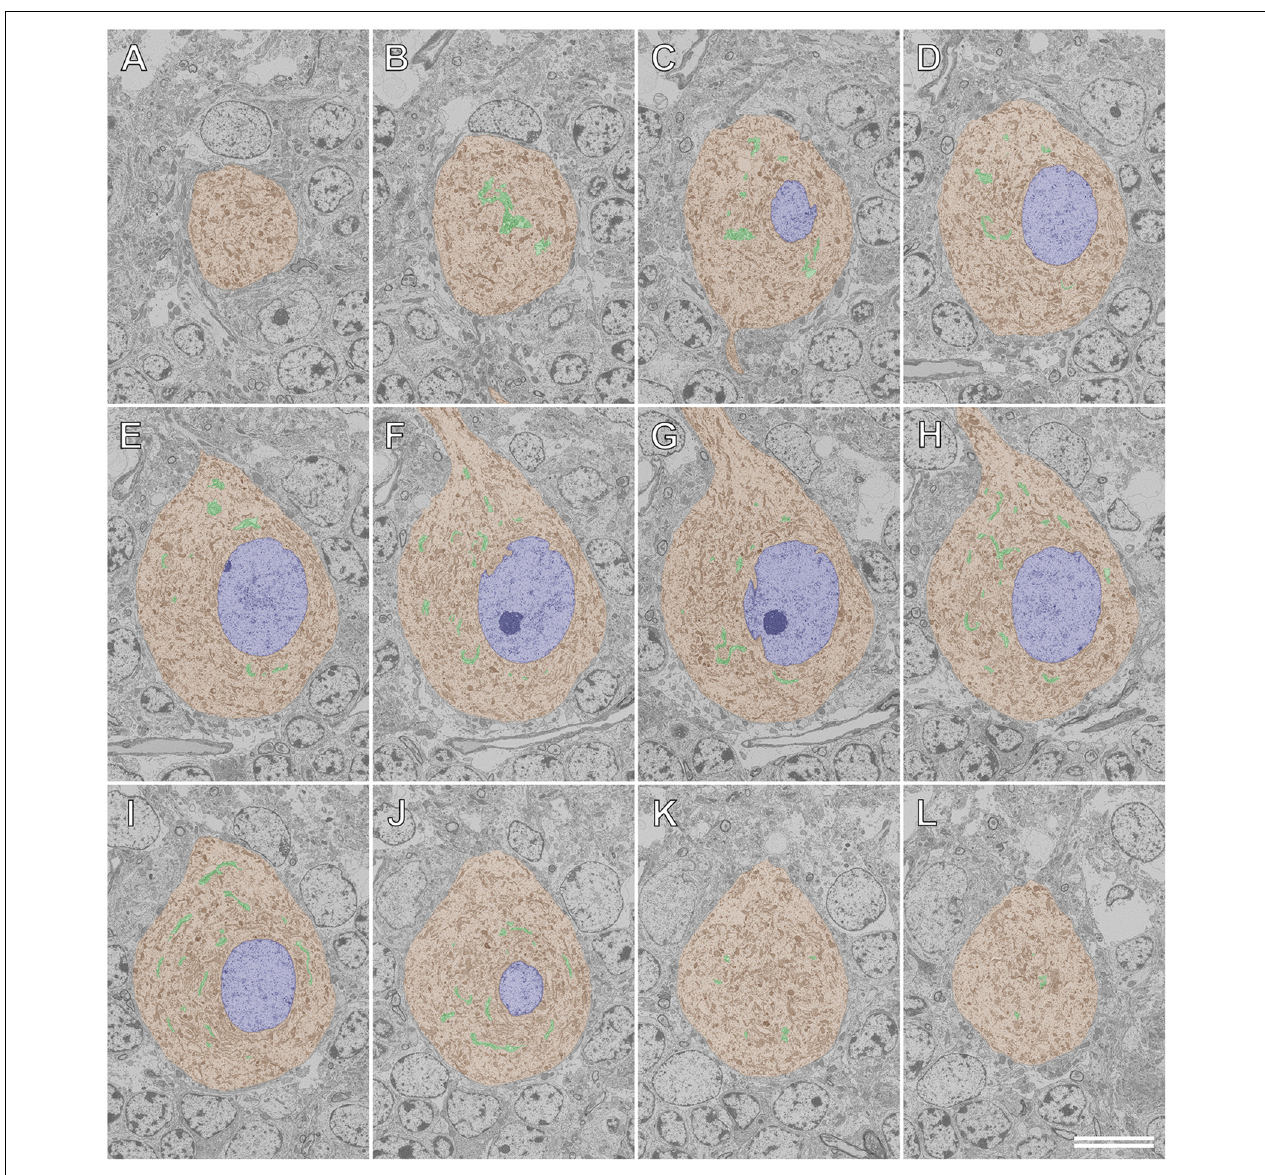
FIGURE 8 | Serial backscattered electron images of ultrathin sections of a Purkinje cell in the rat cerebellum. Section numbers 20 (A) , 40 (B) , 60 (C) , 80 (D) , 100 (E) , 120 (F) , 140 (G) , 160 (H) , 180 (I) , 200 (J) , 220 (K) , and 240 (L) from a set of 281 serial ultrathin sections are shown. The Golgi apparatus, nucleus, and soma of the Purkinje cell are pseudocolored green, blue, and brown, respectively. Scale bar: 10 µ